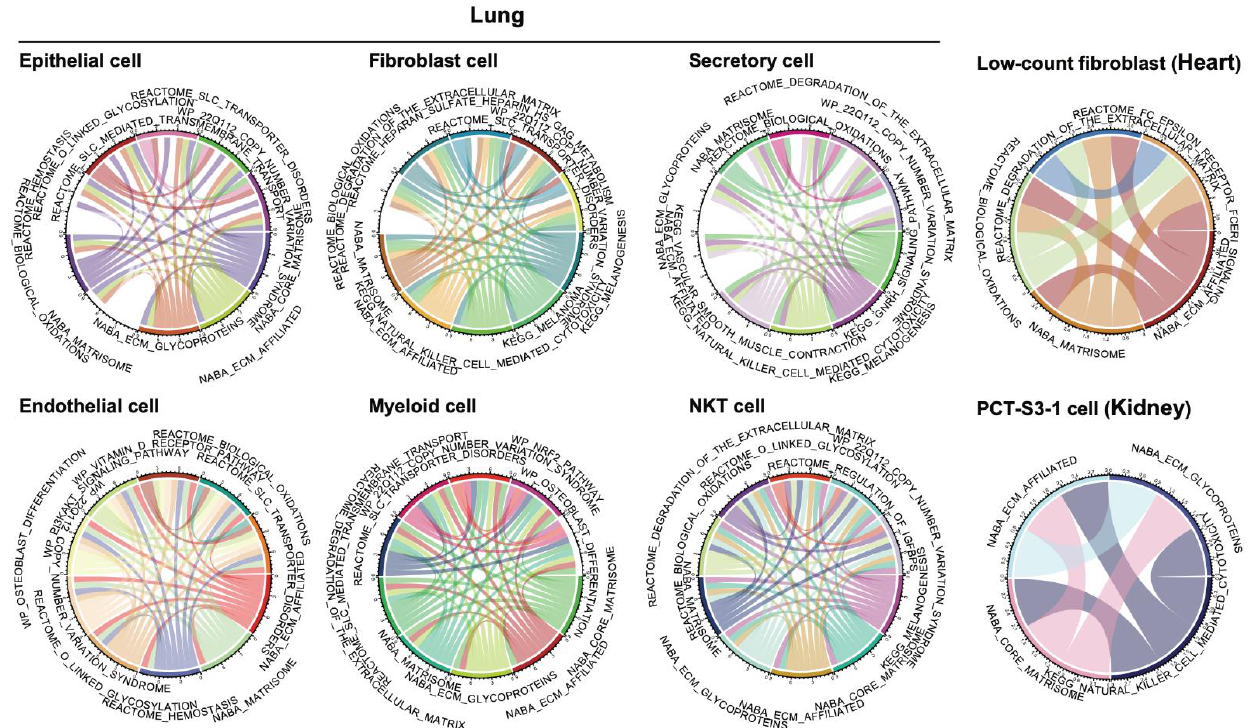
Figure 3. Cell-type-specific profibrotic co-active pathway network. Top-ranked co-active pathways are shown in Circos plot, with a maximum of 10 pathways illustrated. Each plot represents a cell type. Pathway labels are arched and centered to the corresponding segment in the plot. Links between different pathways represent co-activity, with their bandwidths scaled to the percentage of shared active cells.